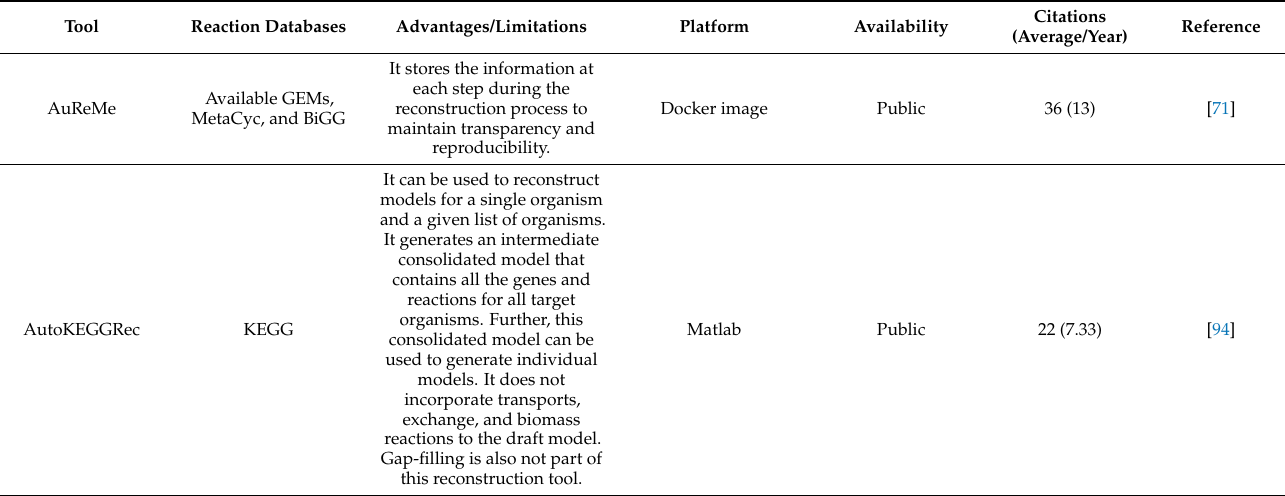
Table 1. Available GEM reconstruction tools and their